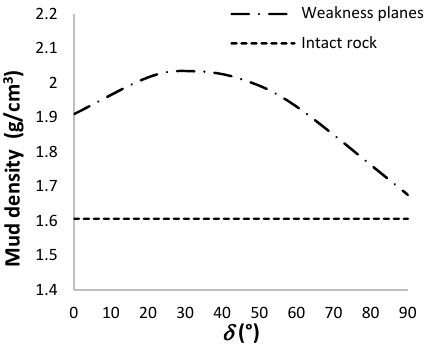
Figure 20. Mud densities to avoid slip for the rock with weakness planes and for the intact rock material in wellbores drilled in the Pedernales Field (Venezuela).